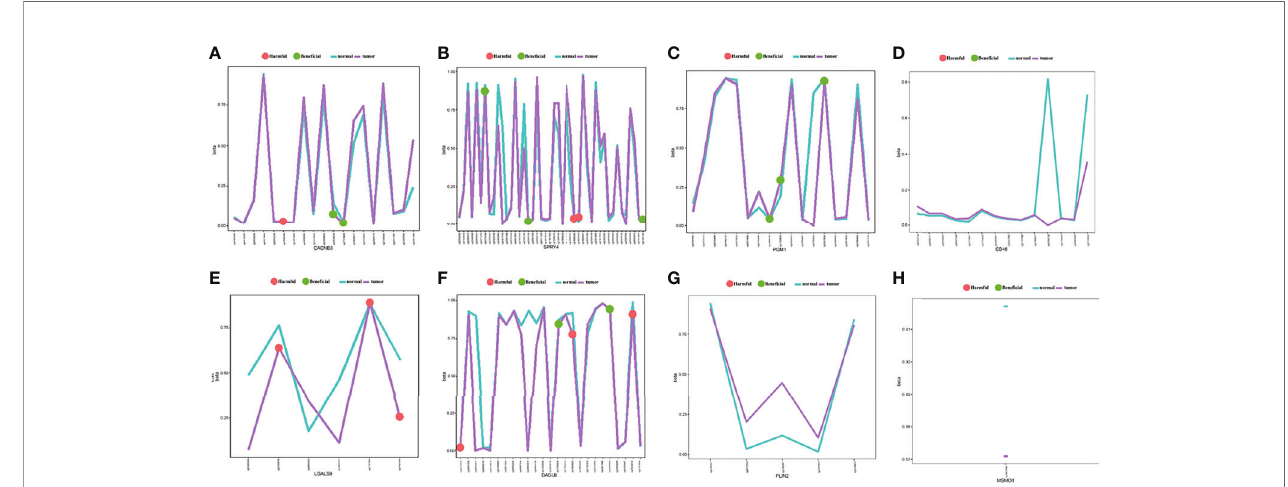
FIGURE 13 | The methylation annotation fi le of the eight prognostic-related genes. Mean gene methylation level and the OS signi fi cance of eight risk signature genes (A) CACNB3, (B) SPRY4, (C) PGM1, (D) CD46, (E) LGALS9, (F) DAGLB, (G) PLIN2, and (H) MSMO1. (green: bene fi cial, red: harmful, turquoise: mean methylation level in normal, purple: mean methylation level in tumor